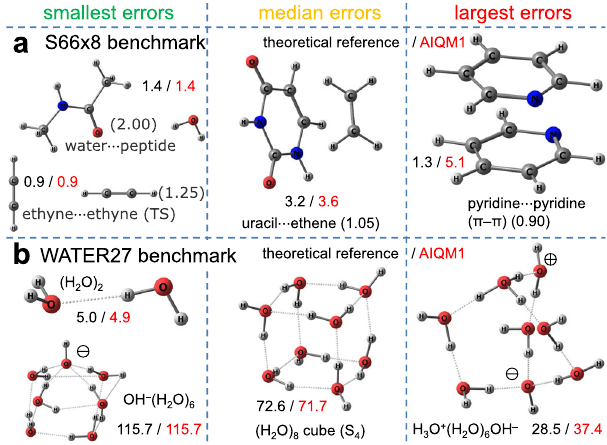
Fig. 8 Performance of the arti fi cial intelligence – quantum mechanical method 1 (AIQM1) for noncovalent interactions. Selection of complexes with errors ranging from smallest to median to largest values for a the S66x8 benchmark and b the WATER27 benchmark. In the fi gure, interaction energies are shown in kcal/mol, black at reference and red at AIQM1. Other numbers such as in “ (1.25) ethyne ⋅⋅⋅ ethyne (TS) ” correspond to the scaling of the distance between monomers relative to equilibrium structures as used for construction of the S66x8